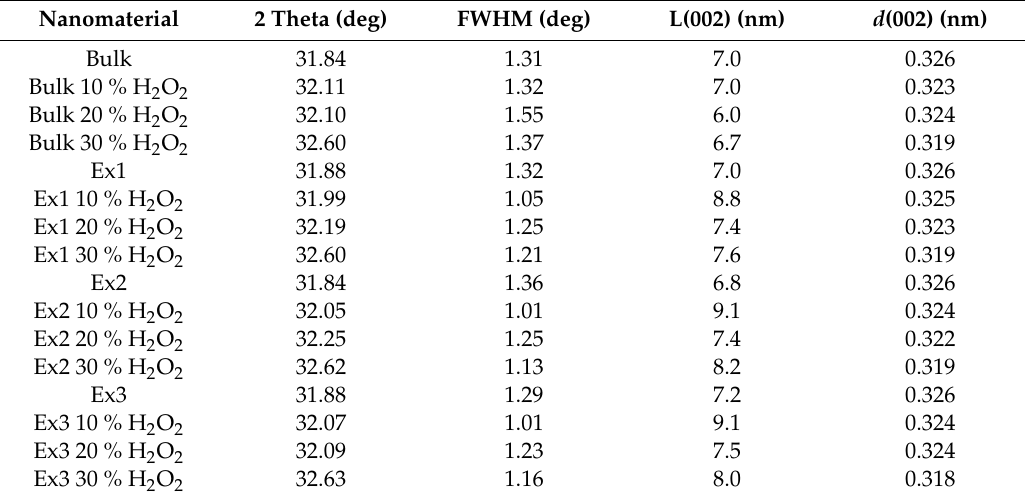
Table 3. XRD characteristics of GCN nanomaterials.